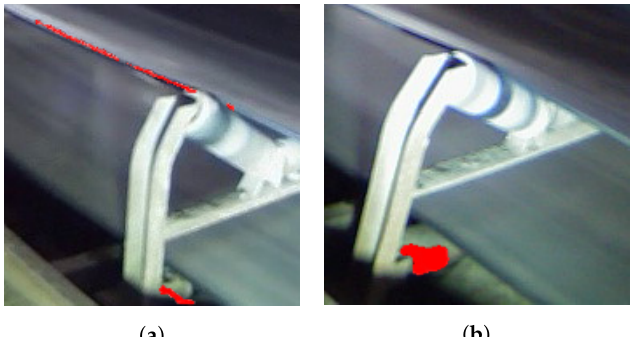
Figure 10. Image annotation process base on fusion of IR and RGB images. ( a ) Segmentation of other thermal sources; ( b ) segmentation of an overheated